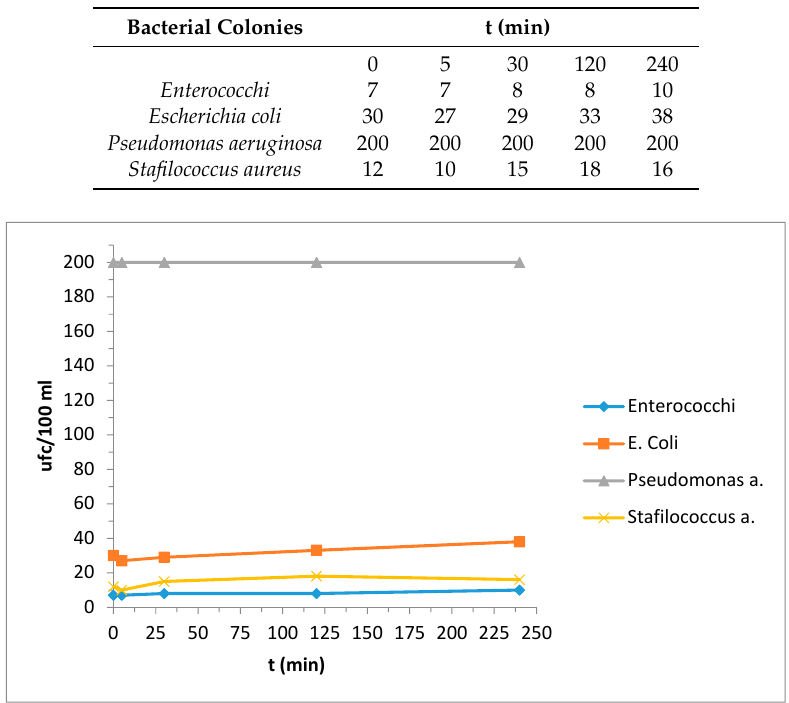
Figure 4. Evaluation of the concentration of the bacterial strains as a function of time. Table 11. Bacterial strains (ufc/100 mL). Table 11. Bacterial strains (ufc/100 mL).